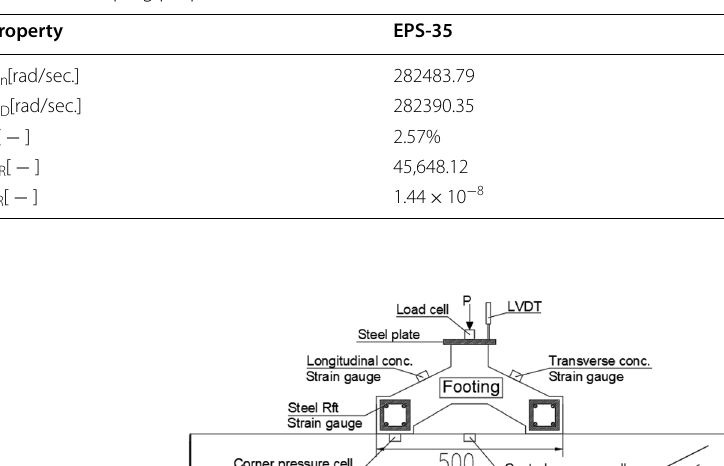
Folded footing test setup